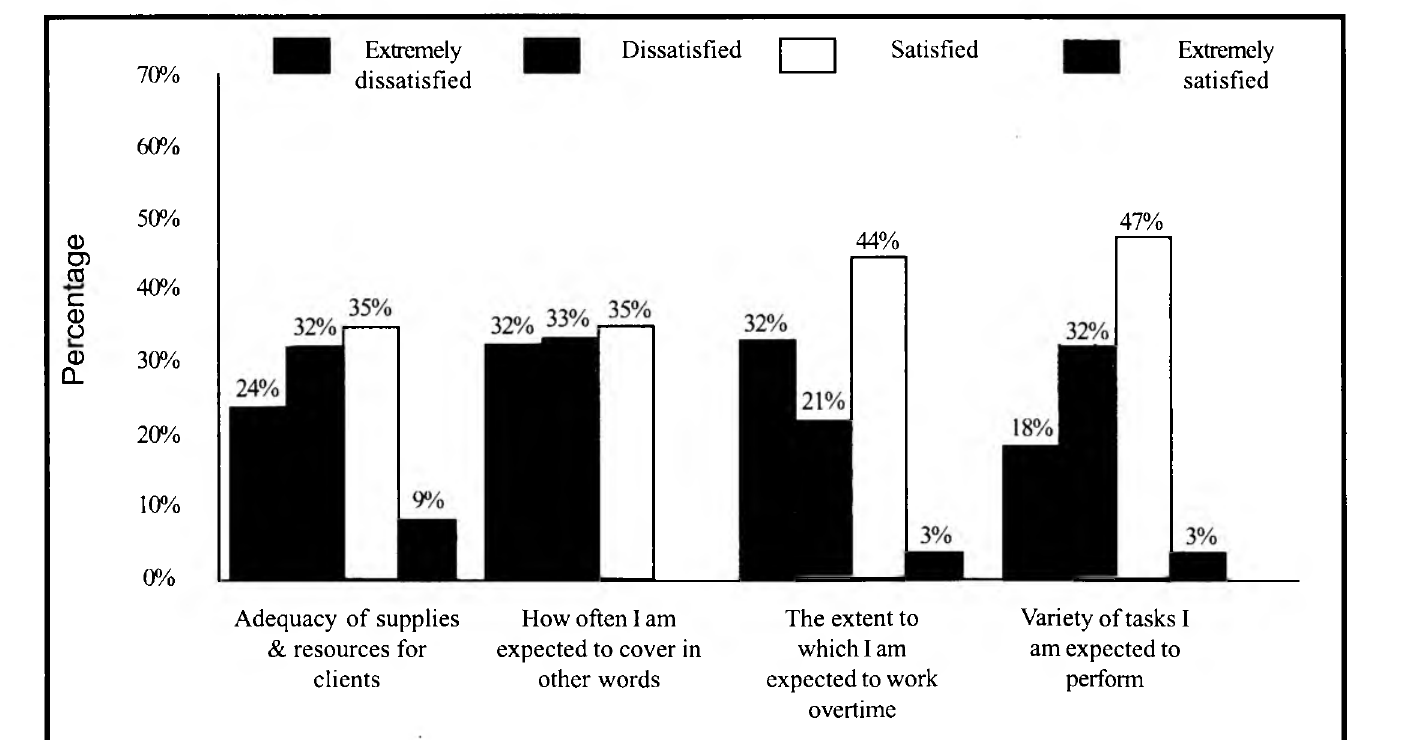
Figure 2: Factors relating to patient care